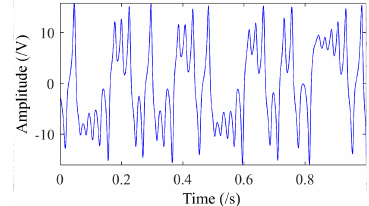
Figure 8. Time domain plot of Lorenz after noise